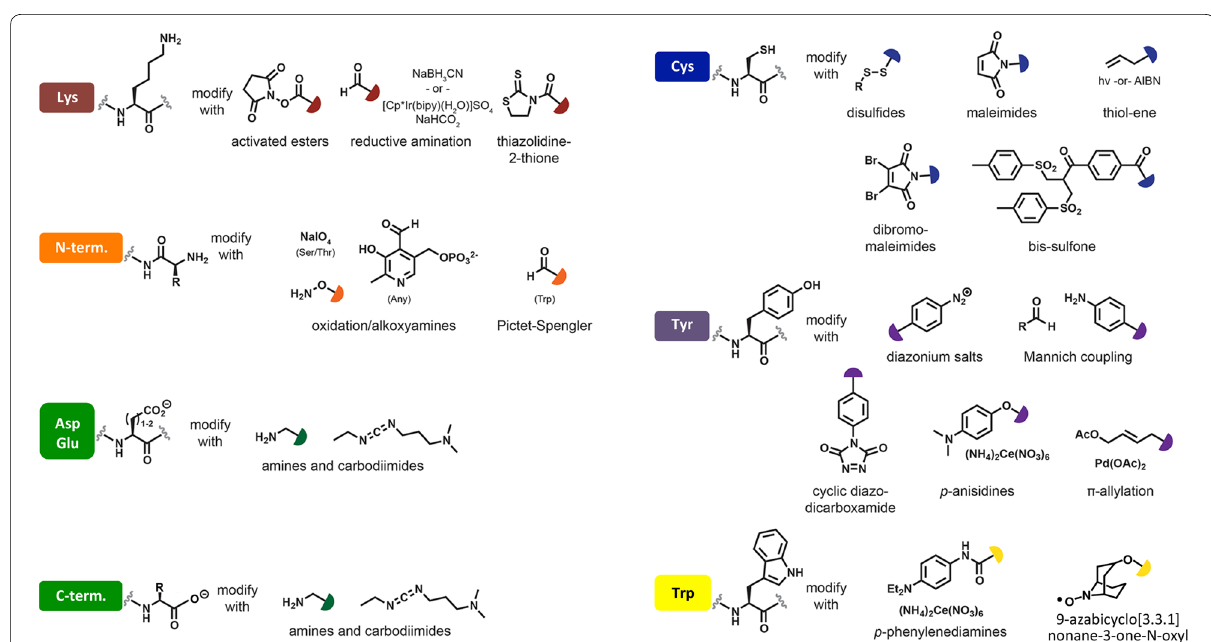
Fig. 19 Standard chemical conjugation technologies for proteins targeting at side chains of natural AA (Figure adapted with permission from: Ref. [213]. Copyright (2015) American Chemical